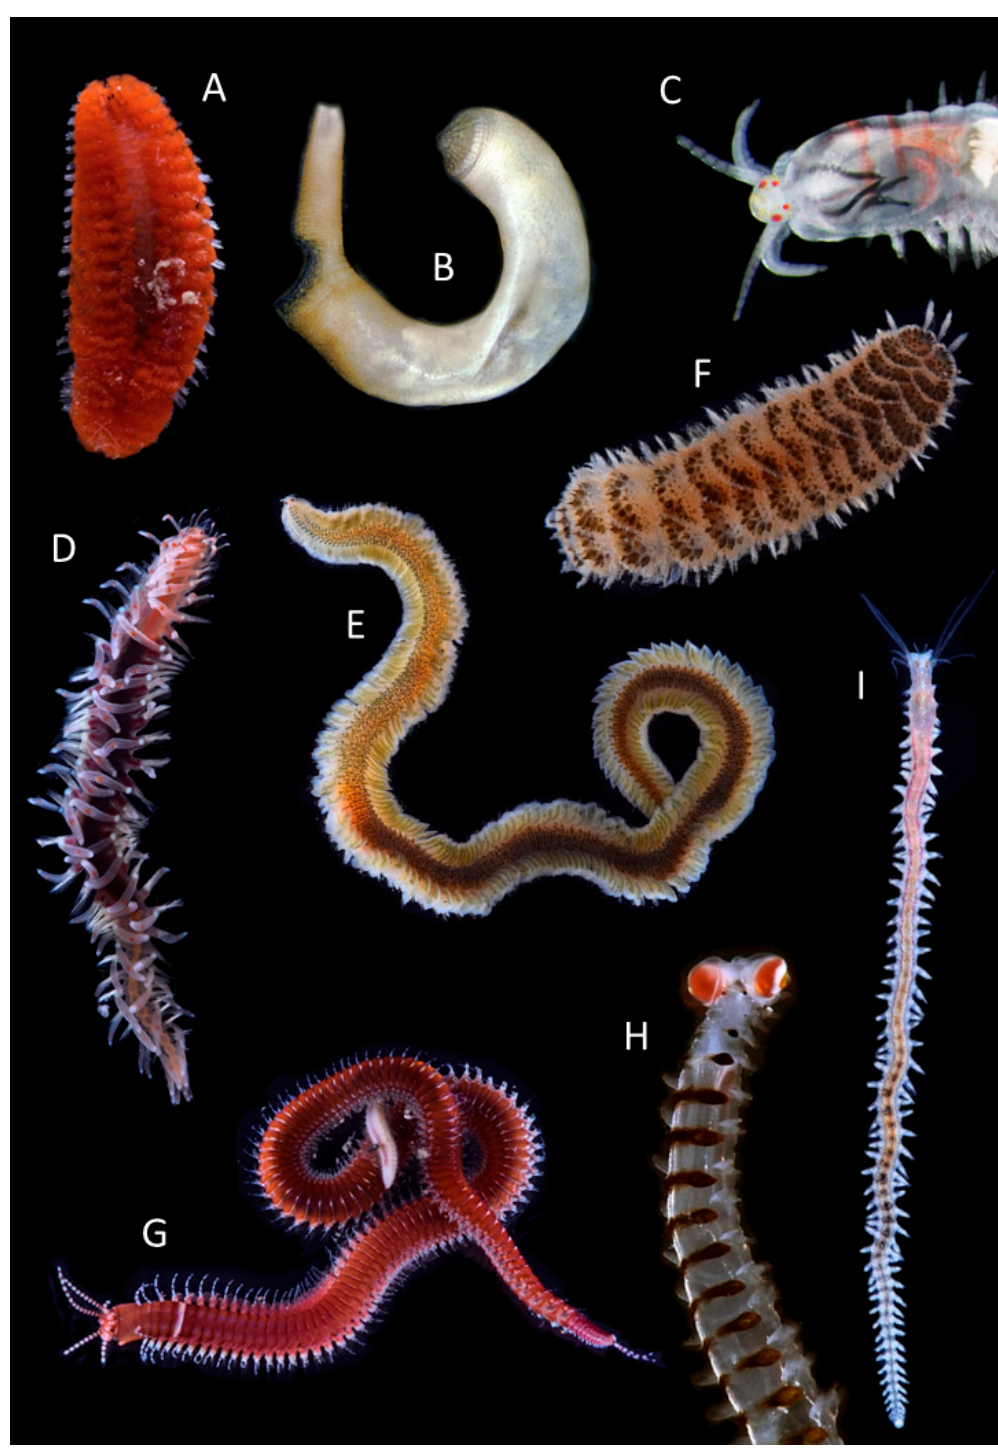
Figure 1. Small selection of some basal annelids ( A , B ) and Errantia ( C – I ). ( A ). Euphrosine foliosa Audouin & H Milne Edwards, 1833 (Amphinomida); ( B ). Aspidosiphon muelleri Diesing, 1851 (Sipuncula); C . Dorvillea similis (Crossland, 1924) (Eunicida); ( D ). Amphiduros fuscescens (Marenzeller, 1875) (Phyllodocida); ( E ). Phyllodoce sp. (Phyllodocida); ( F ). Harmothoe areolata (Grube, 1860) ( Phyllodocida); ( G ). Eunice cf. dubitata Fauchald, 1974 (Eunicida); ( H ) . Vanadis Formosa Claparède, 1870 (Phyllodocida); Nereis sp. (Phyllodocida). Photos: ( A , D – I ) by Xavier Salvador Costa; ( B ) by Daniel Martin; ( C ) by Alexander Semenov.